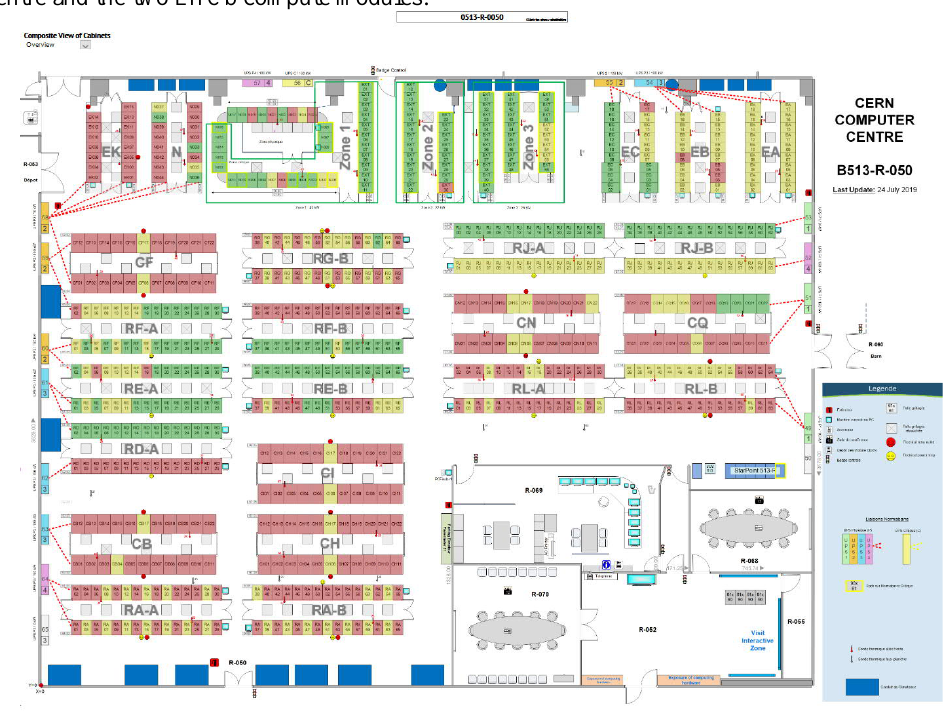
Figure 1: Schematic floor plan of R-050. The rack colours reflect the occupancy (green is